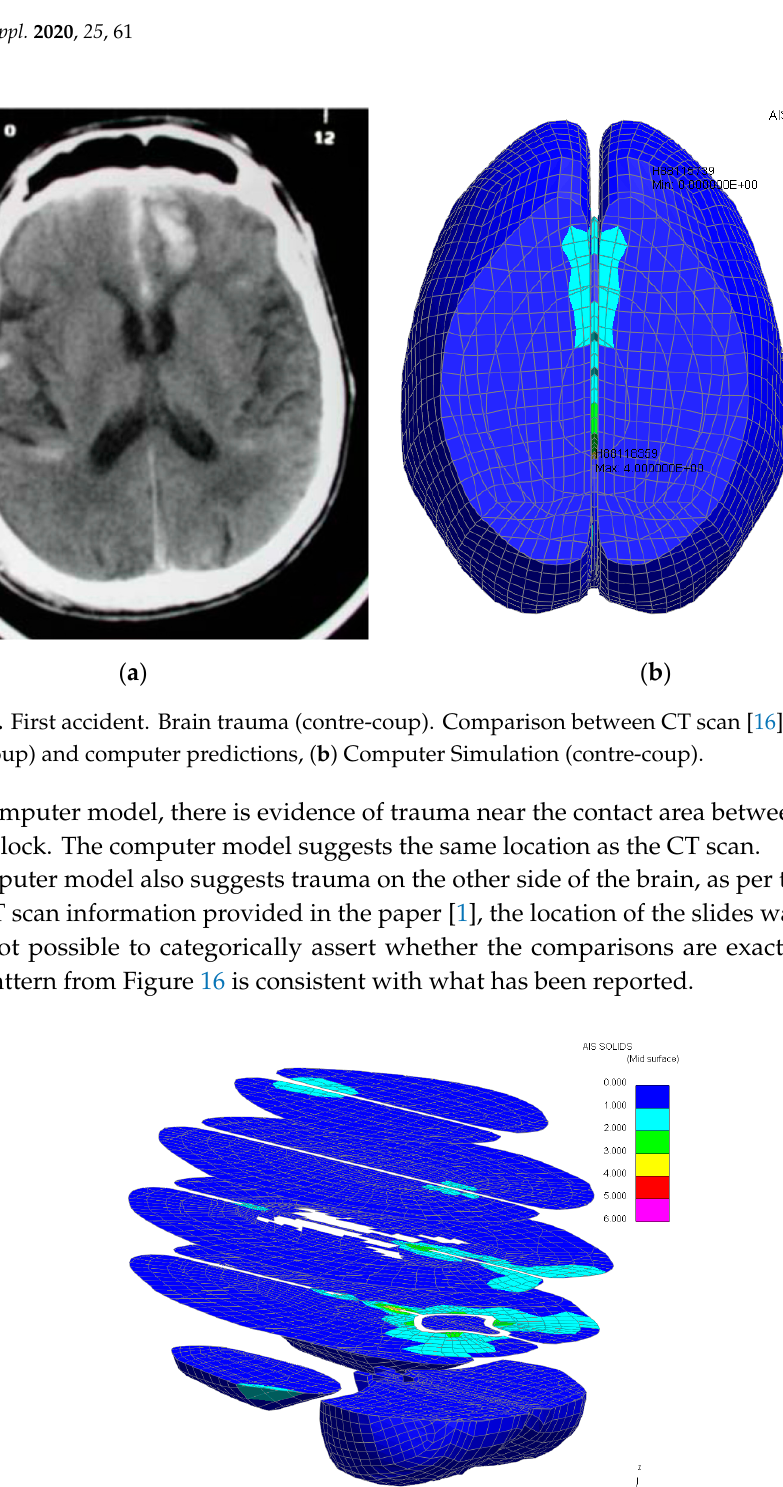
Figure 14. First Accident. Brain trauma (coup). Comparison between CT scan [16] ( a ) CT Scan (coup)